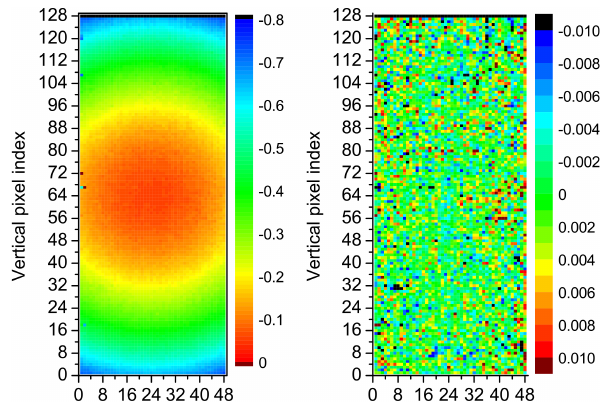
Figure 8. Apparent line position for the CO 2 line at 951.19cm − 1 across the detector array before (left) and after spectral calibration (right). The colours denote the shift with respect to the HITRAN position in cm − 1